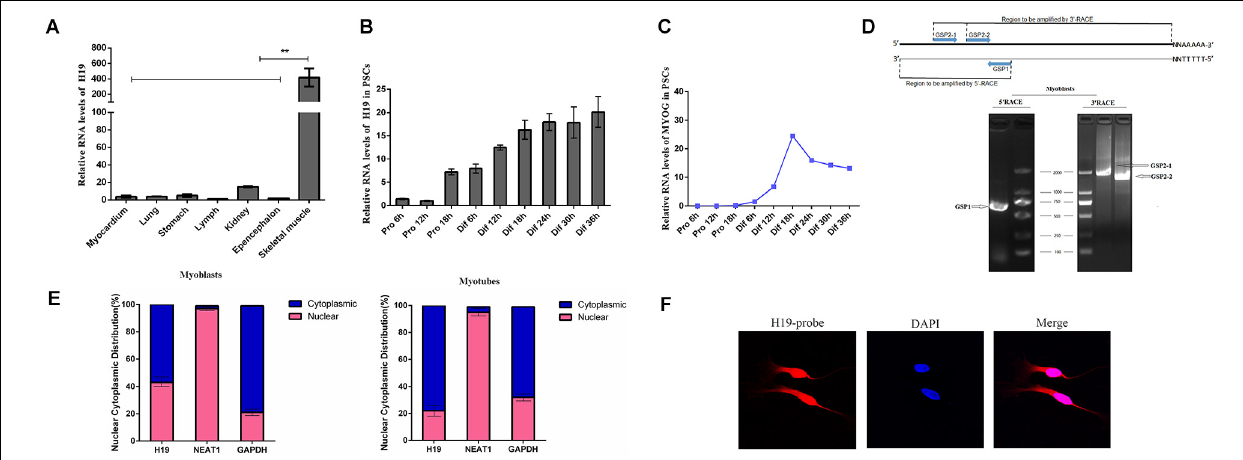
FIGURE 1 | Expression pattern and characterization of H19. (A) Real-time PCR analysis of H19 expression in different tissues of Yorkshire. Mean values ± SEM, n = 3, ** P < 0.01. (B) Real-time PCR analysis of H19 expression in PSCs during the period of proliferation and differentiation. There is a 6-h interval between each period. Mean values ± SEM, n = 3. (C) Real-time PCR analysis of MYOG, MYOD, and MYHC expression in PSCs during the period of proliferation and differentiation. There is a 6-h interval between each period. Mean values ± SEM, n = 3. (D) Agarose gelelectrophoresis showing the 5 (cid:48) and 3 (cid:48) RACE results of H19 for 2 days’ proliferation. Left, 5 (cid:48) RACE product of GSP1 (710 bp); right, 3 (cid:48) RACE product of GSP2-1 (1922 bp) and GSP2-2 (1597 bp). (E) RNA of PSCs was fractionated into nuclei and cytosol fractions. H19 subcellular distribution was calculated by qPCR assay data, the graphs showed the expression in myoblasts and myotubes, and NEAT1 and GAPDH were used as the nuclear control and cytoplasmic control, respectively. (F) Confocal FISH images showing localization of H19 in PSCs.